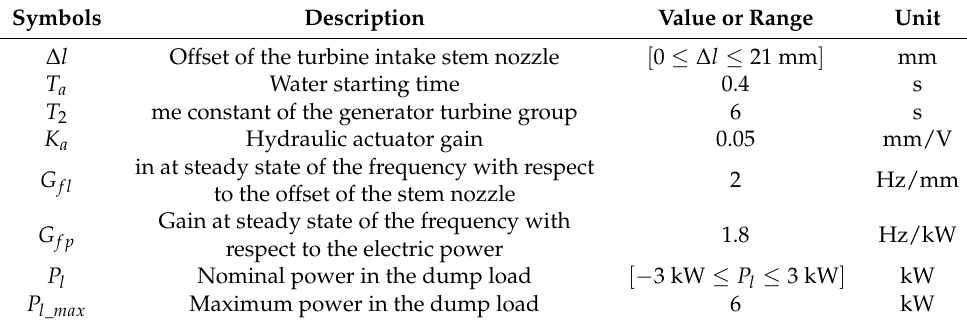
Table 1. Description of the values of the model considered for the case study